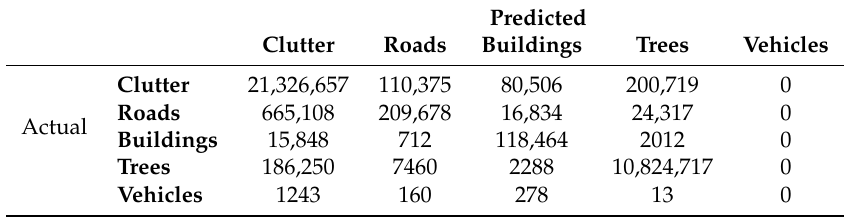
Table A8. Confusion matrix for the CNN model that is trained on colors, after 50